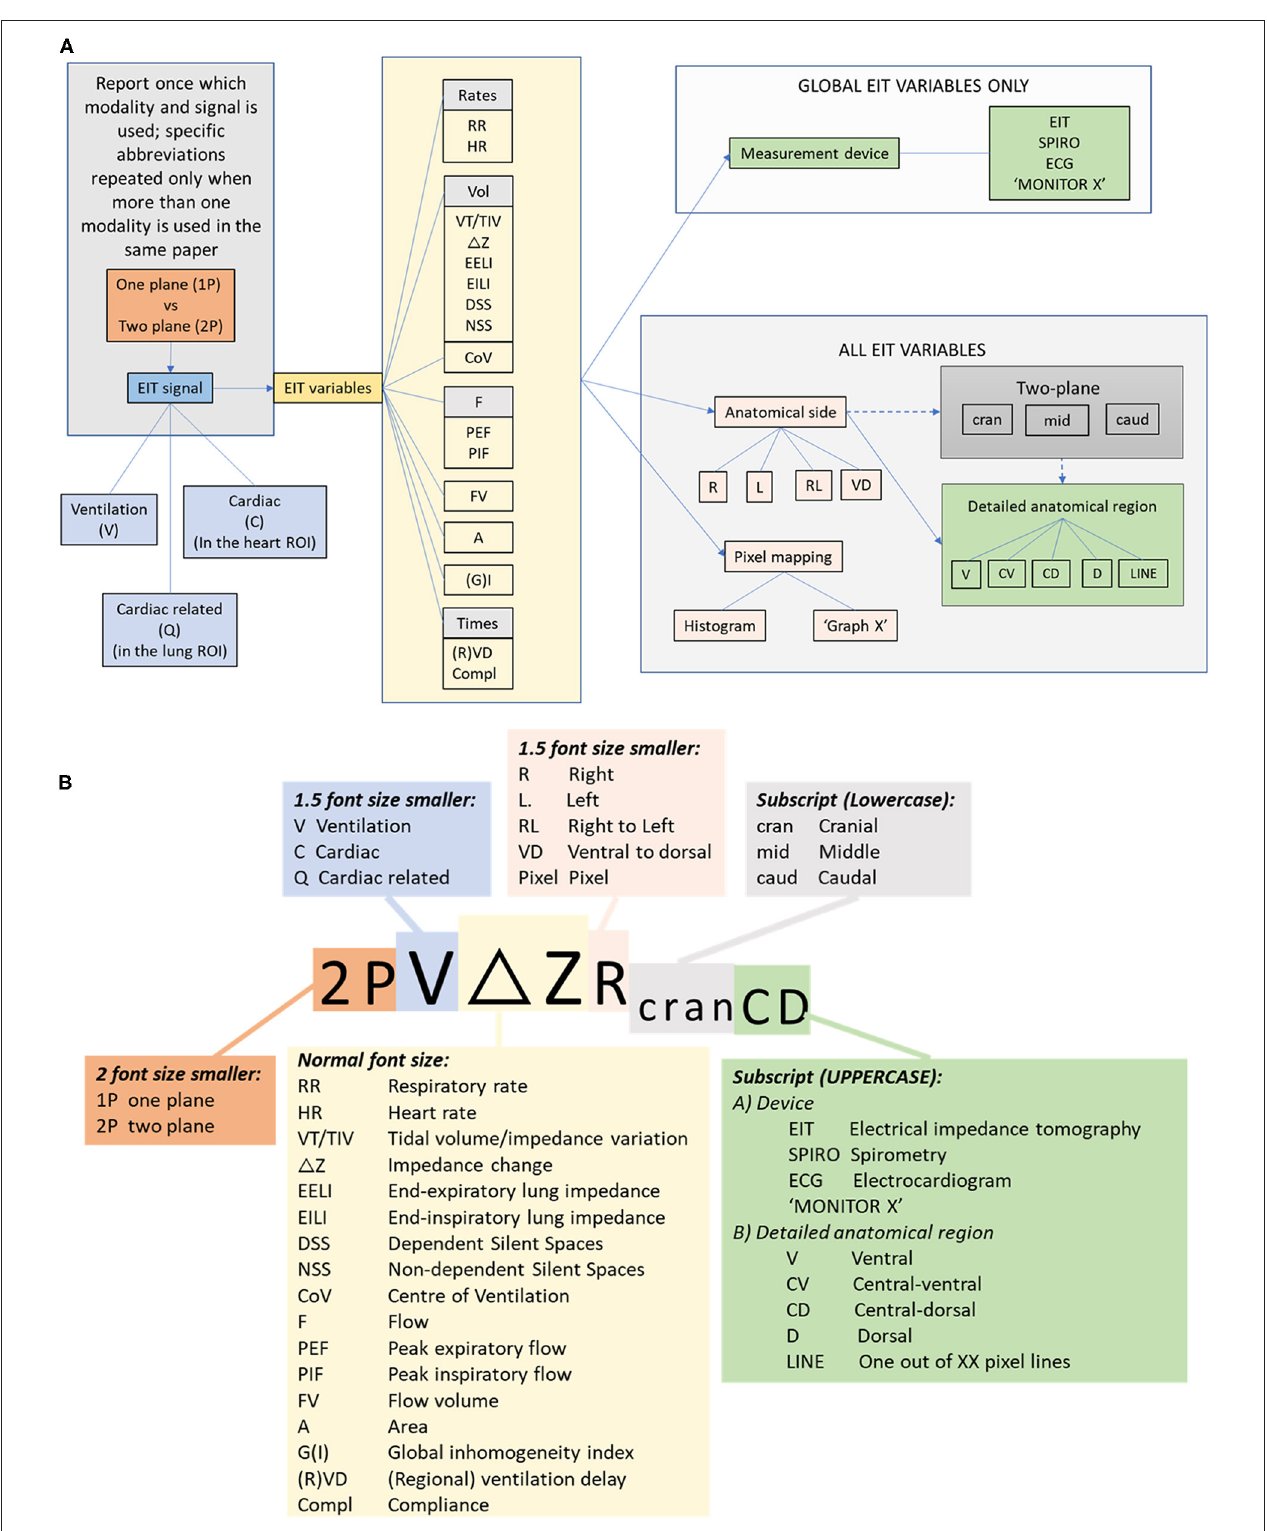
FIGURE 10 | (A) Flow chart for description of EIT variables incorporating modality, signal, variable and localising descriptors. (B) Algorithm for abbreviation generation.